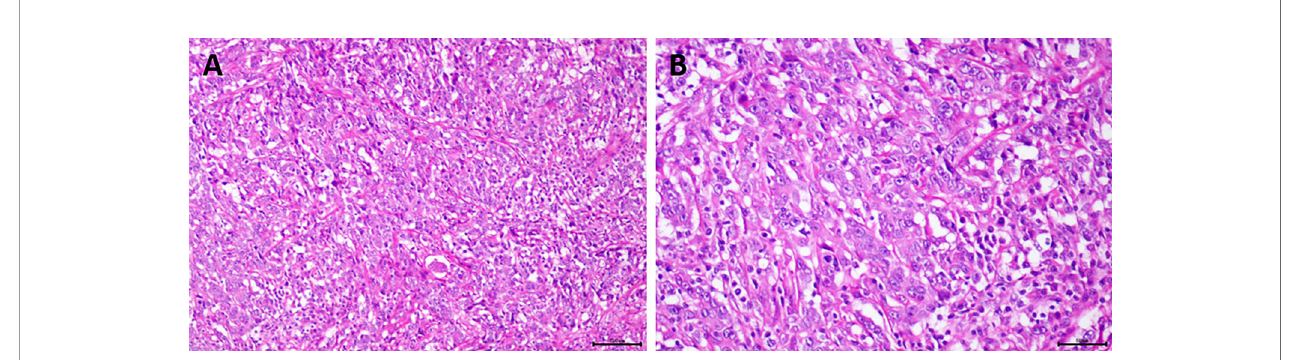
FIGURE 6 | The postoperative pathological examination of the patient showed the tumor bed contained necrotic fi brous tissue proliferation, chronic in fl ammatory cell in fi ltration, cholesterol crystallization, and hemosiderin deposition, and low-grade intraepithelial neoplasia was seen in the surrounding bile duct. (A) Hematoxylin and eosin (H&E), original magni fi cation ×100; (B) H&E, original magni fi cation